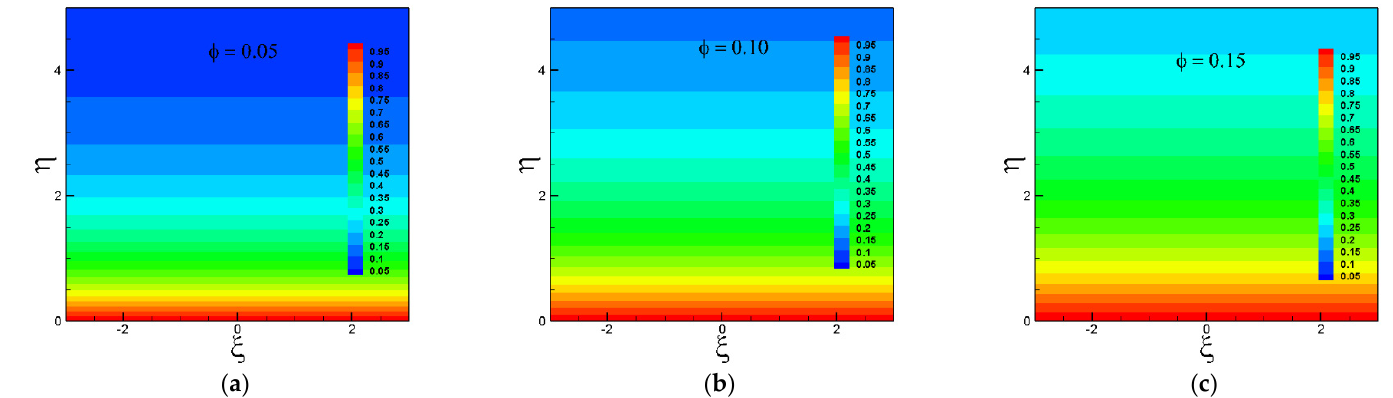
Figure 5. ( a ). Isotherm with 𝝓 = 𝟎. 𝟎𝟓 . ( b ). Isotherm with 𝝓 = 𝟎.𝟏𝟎 . ( c ). Isotherm with 𝝓 = 𝟎. 𝟏𝟓 .